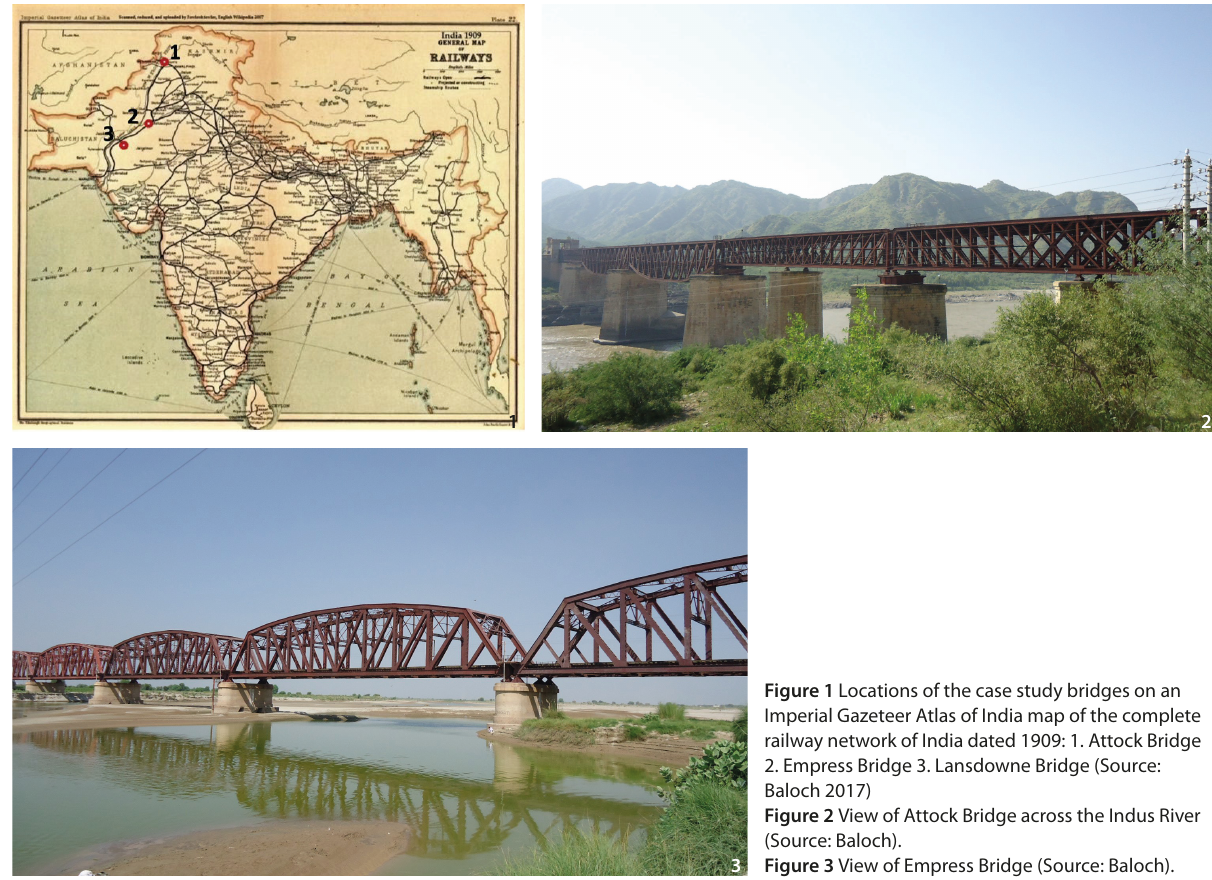
Figure 1 Locations of the case study bridges on an Imperial Gazeteer Atlas of India map of the complete railway network of India dated 1909: 1. Attock Bridge 2. Empress Bridge 3. Lansdowne Bridge (Source: Baloch 2017) Figure 2 View of Attock Bridge across the Indus River (Source: Baloch). Figure 3 View of Empress Bridge (Source: